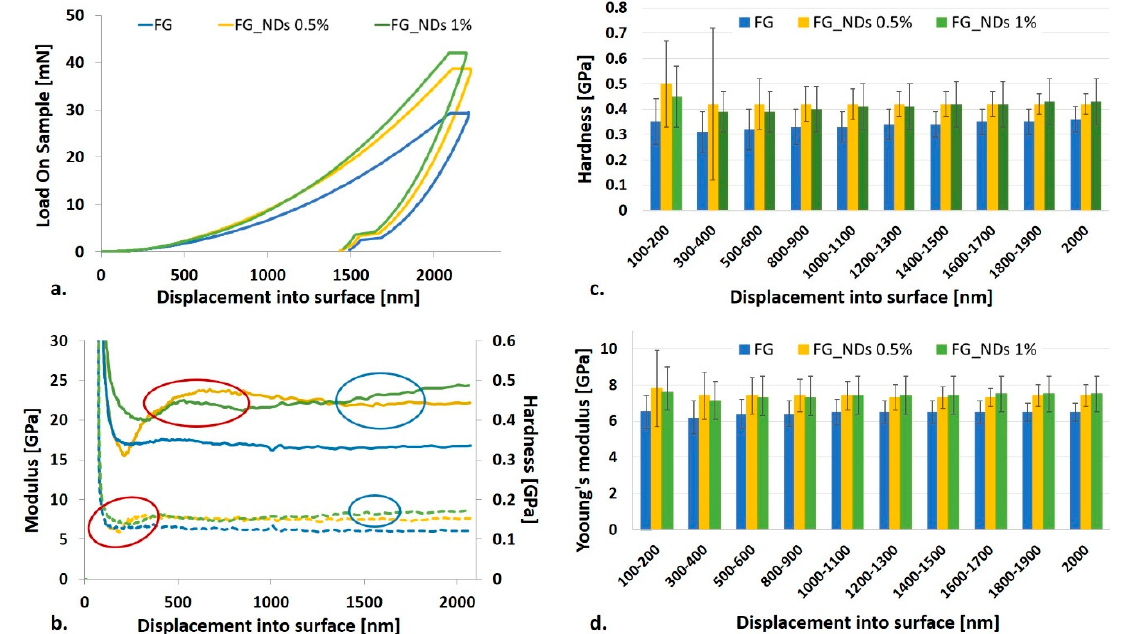
Figure 4. Influence of NDs loading on the nanomechanical properties of FG_NDs ( a ) load as function of penetration depth; ( b ) representative variation of modulus (top—dotted lines) and hardness (bottom—plain lines) up to a maximum depth of 2000 nm; red circles—the effect on FG-ND 0.5% which could be attributed to the presence of nanoparticles aggregates; blue circles—the expected behavior which appear with indentation depth increase; ( c ) hardness as a function of the indentation depth; ( d ) Young’s modulus as a function of the indentation depth.